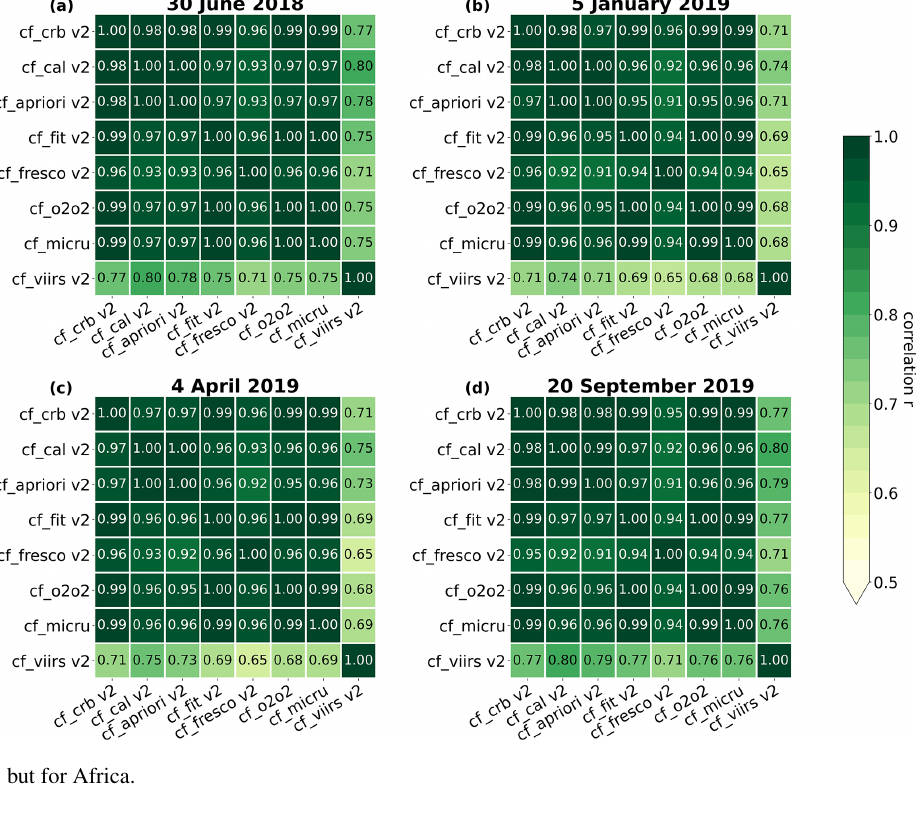
Figure 6. As Fig. 5 but for Africa.